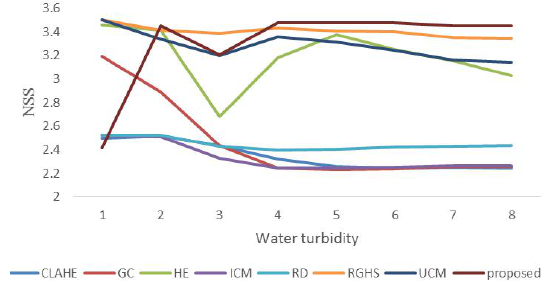
Figure 7. NSS of different methods in Fig.3 (a)Original